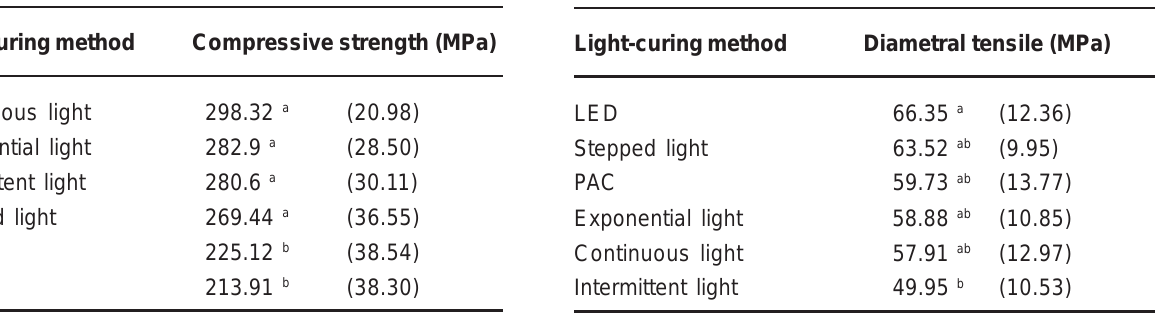
TABLE 2- Means of compressive strength of Z250 composite resin